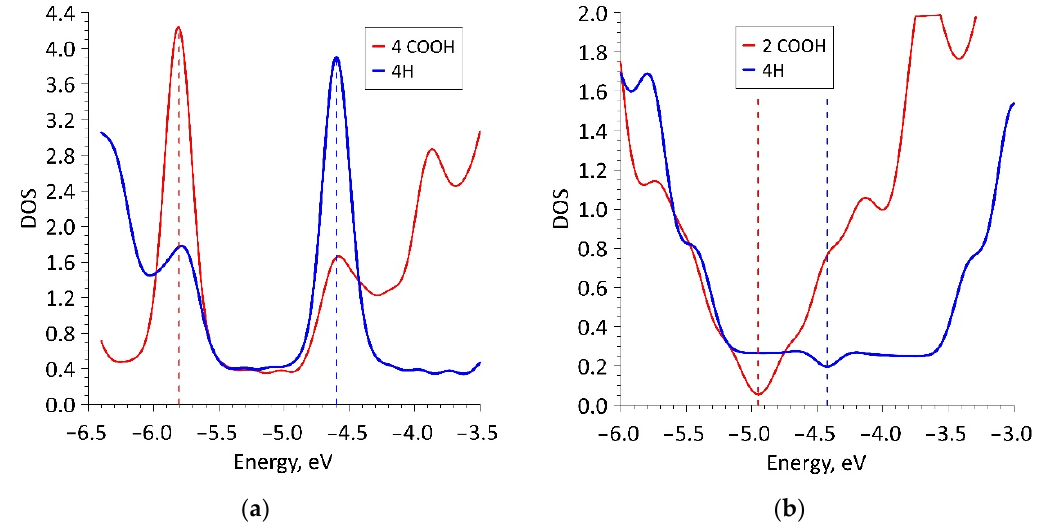
Figure 2. DOS plots of carboxylated graphene nanoribbons: ( a ) zigzag nanoribbon; ( b ) armchair nanoribbon.